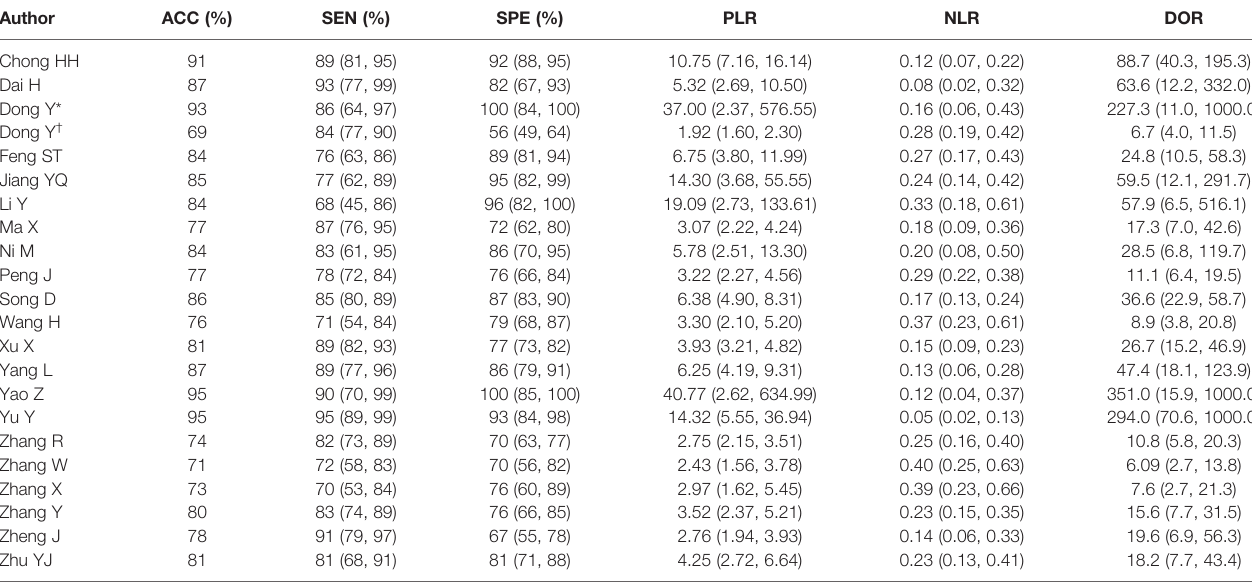
TABLE 2 | Sensitivity analysis based on radiomics for the preoperative prediction of microvascular invasion in hepatocellular carcinoma. Author